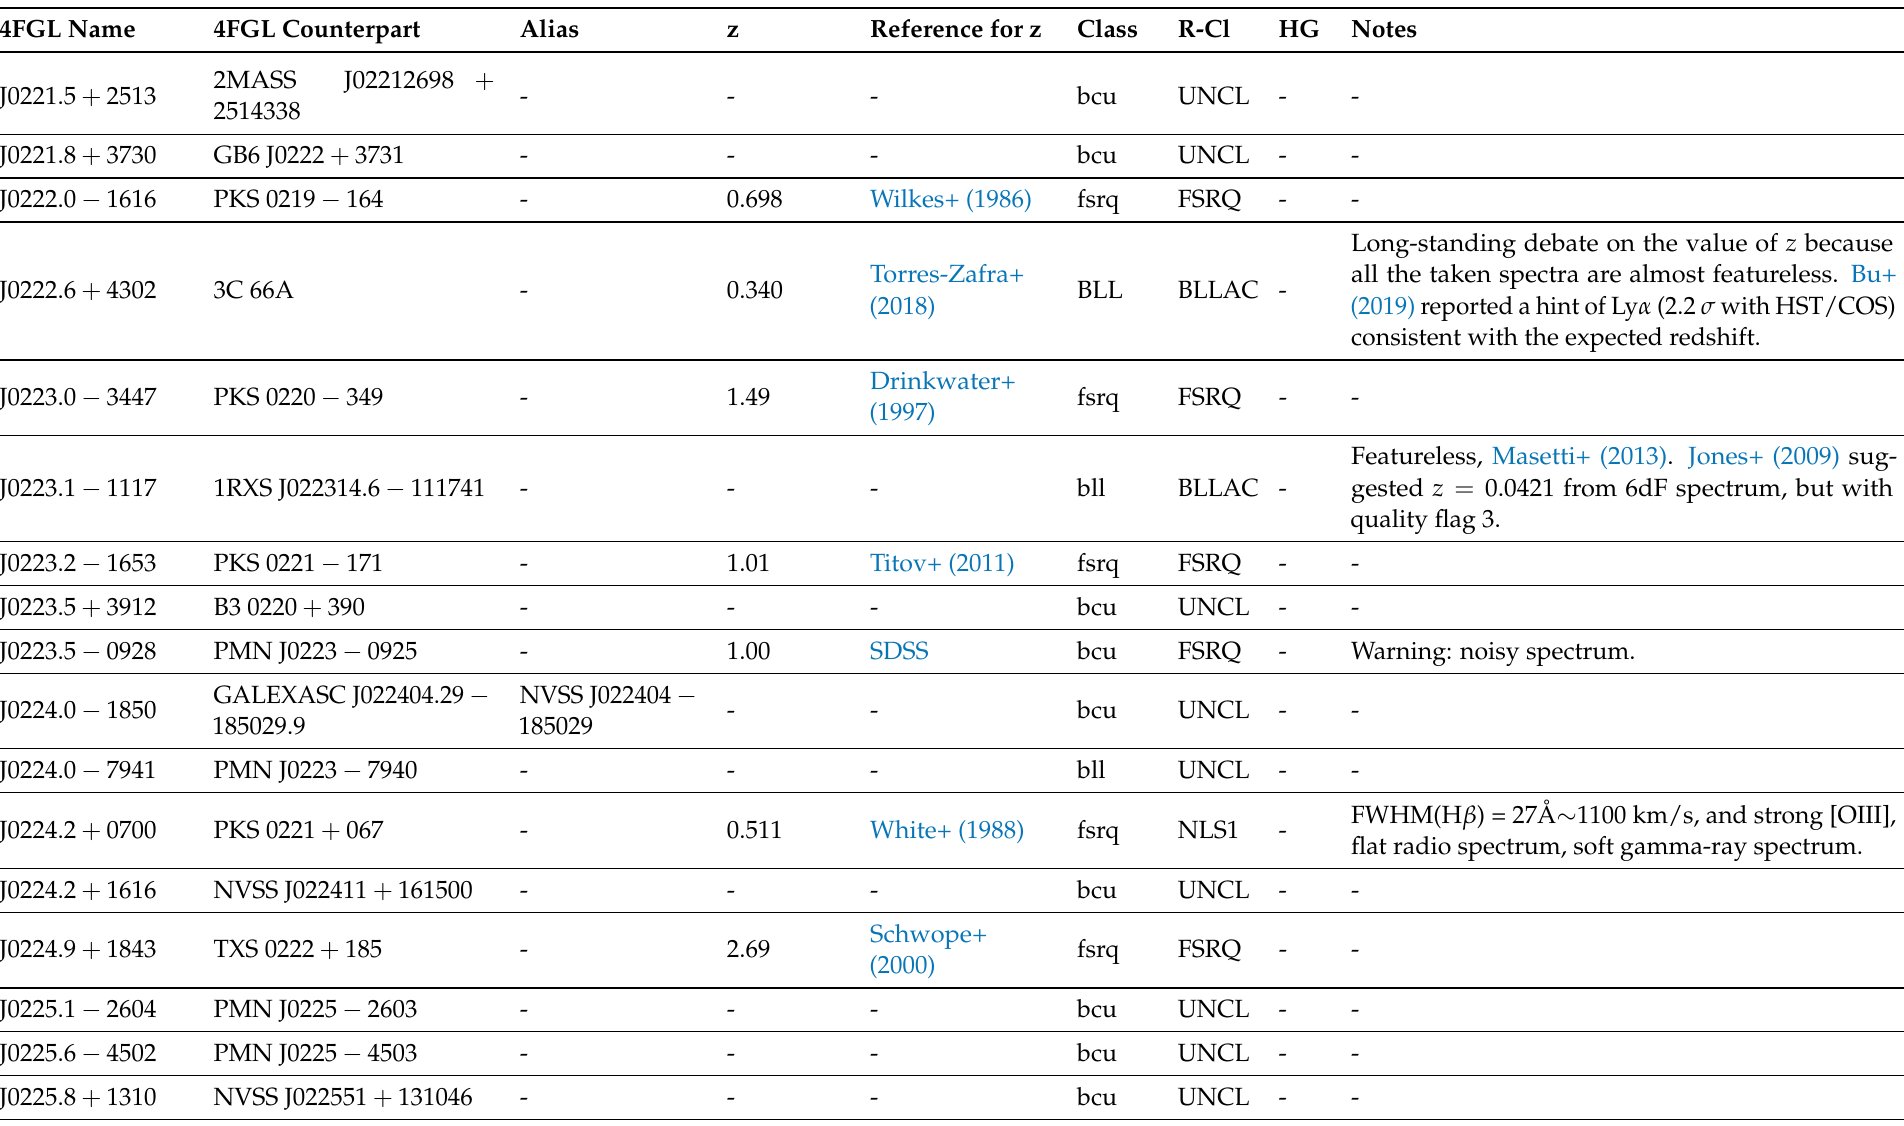
FWHM(H β ) = 27Å ∼ 1100 km/s, and strong [OIII], NLS1 - flat radio spectrum, soft gamma-ray